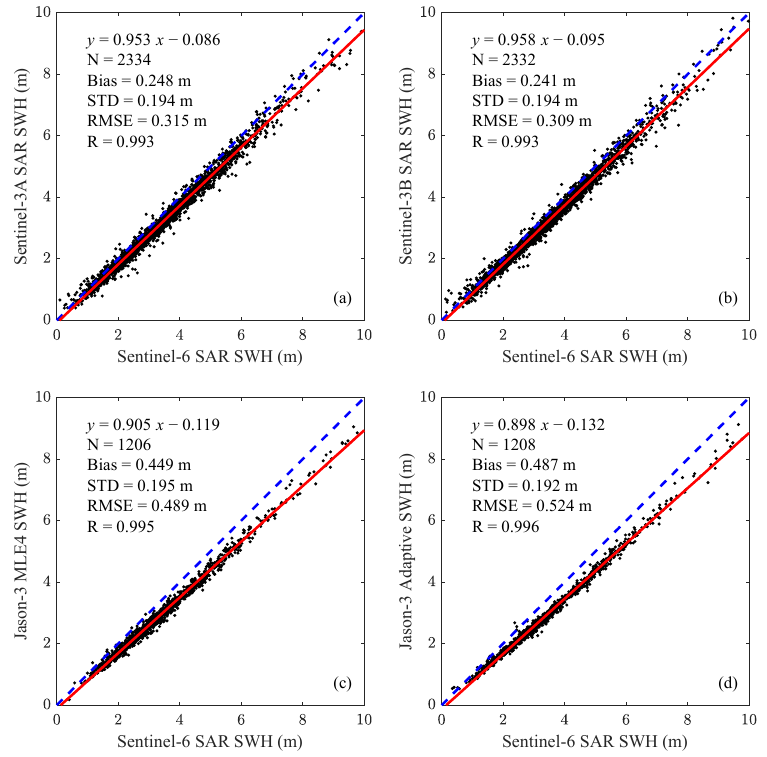
Figure 13. Scatterplots of Sentinel-6 SWH measurements in SARM against ( a ) Sentinel-3A SARM, ( b ) Sentinel-3B SARM, ( c ) Jason-3 MLE-4 and ( d ) Jason-3 adaptive re-tracking measurements.